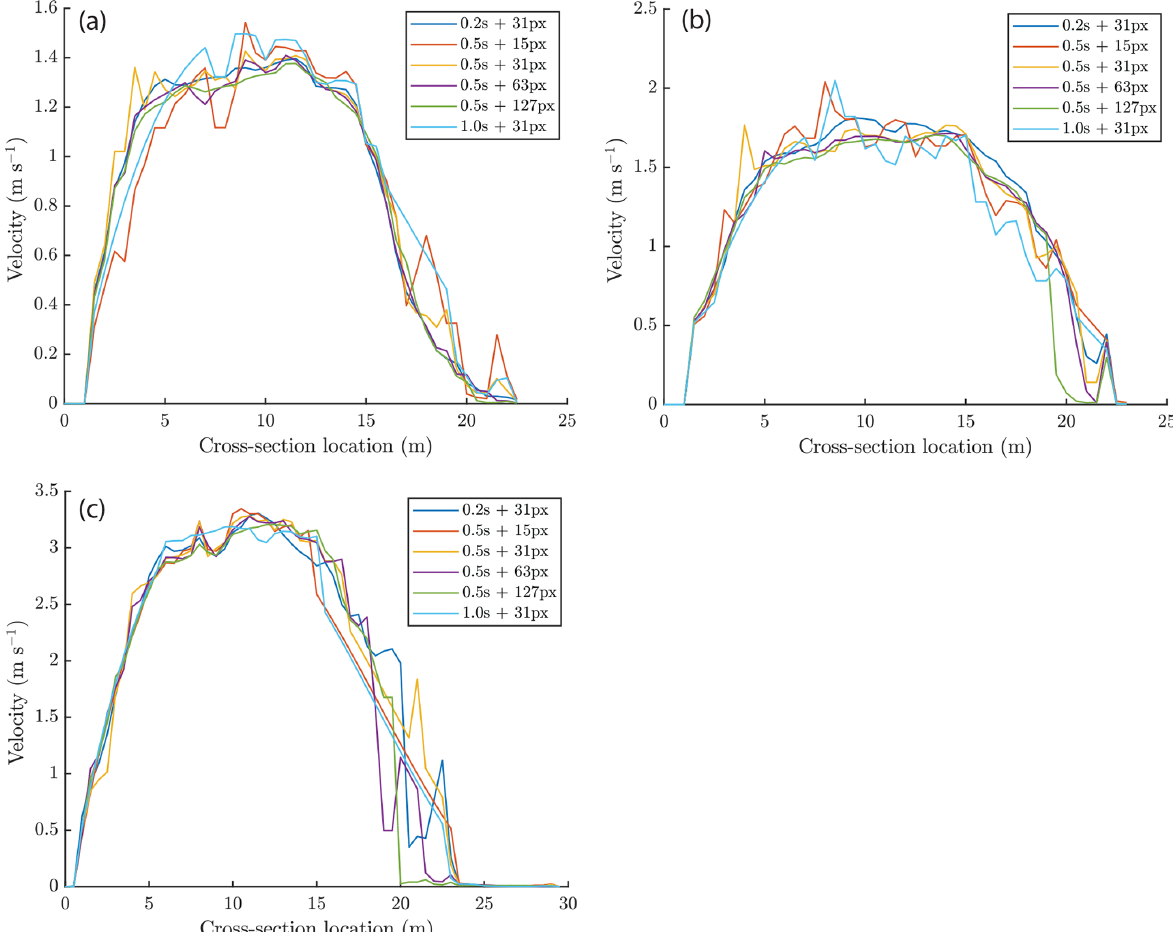
Figure C1. An illustration of the sensitivity of KLT-IV v1.0 to variations in main settings that can be defined by the user: (i) extract rate (s) and (ii) block size (px). A number of setting combinations with extract rates varying between 0.2 and 1s and block sizes ranging from 15 to 127 px are displayed. Outputs displayed are all based on footage acquired using the fixed camera at the river Feshie at river stages of 0.885m (a) , 1.204m (b) , and 1.762m (c) . These correspond with video numbers 8, 2, and 6 respectively in the data